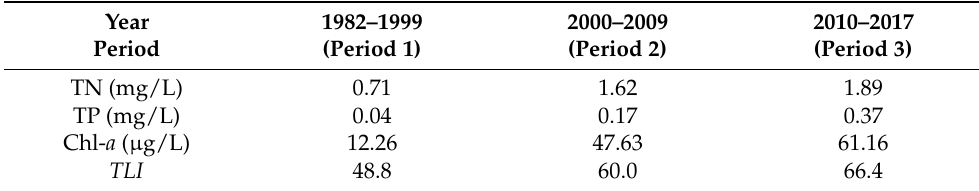
Figure 7. Annual concentrations of TN (blue), TP (red), Chl- a (green), and TLI (purple) at Lake Xingyun for 1982–2017 (no TN and TP data for 1983–1987, no Chl- a data for 1983, 1985–1992, 1994–1998, and 2000–2001, and no TLI data for 1982–1995). Table 4. Average TN, TP, and Chl- a concentrations and TLI for the periods of 1982–1999, 2000–2009, and 2010–2017 at Lake Xingyun.